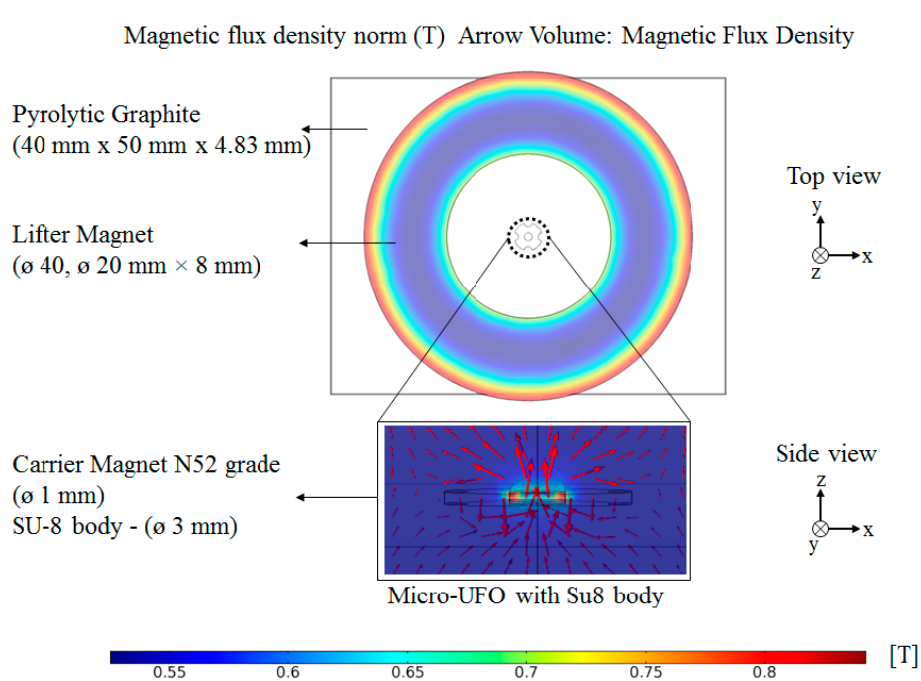
Figure 3. The effect of the magnetic field on the micro-UFO and the measurements of the materials used are shown. As expected in the lifter magnet, the magnetic field is seen with a higher [T] (red color), due to the polarity of the pole lines in the corner regions. In the micro-UFO, the same situation is seen in the magnified image. It has also been shown that the lines are in the z -axis direction (side view) since the magnets are placed in N-S-N-S. Used computer: Intel Xeon E4820 * 4 processors (32 core), 128 GB RAM.